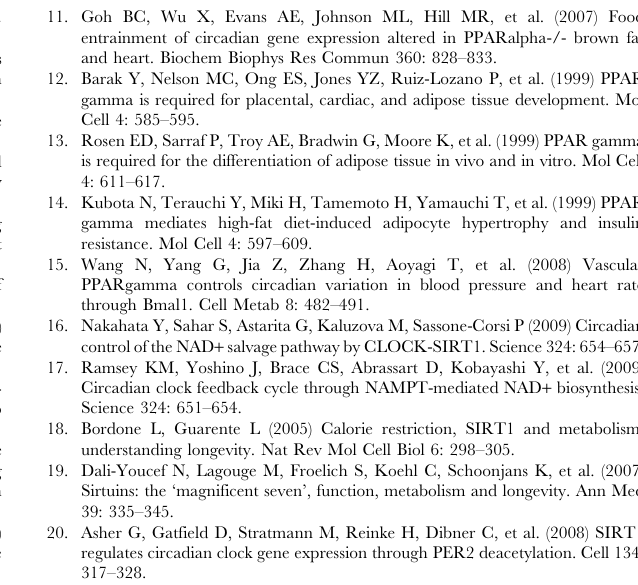
Figure S1 Comparison of the free-running period of wild-type controls. The free-running period of C57BL/6J (n= 5), AMPK a 1 + / + (n= 5) and AMPK a 2 + / + (n= 7) mice are shown. The free-running period was determined by using the x 2 periodogram for days 1–14 in DD. Result is expressed as means 6 SEM.